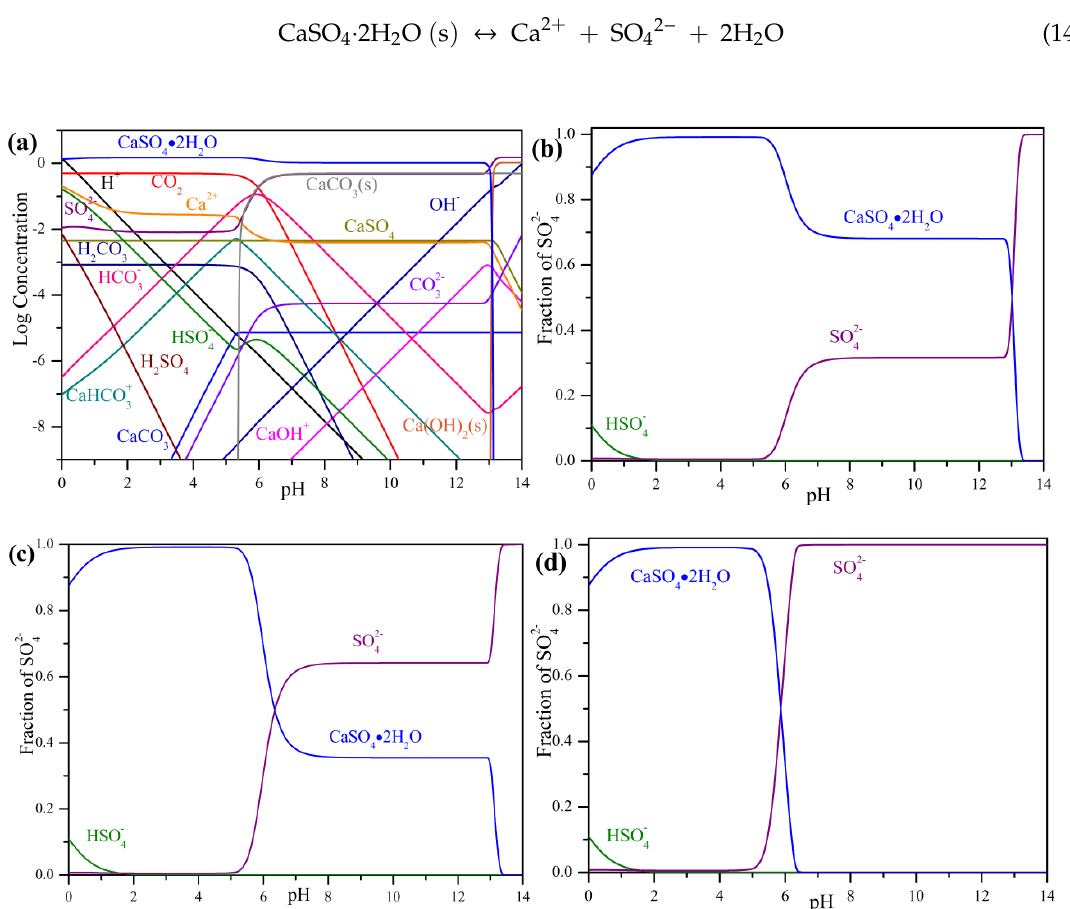
= 0.1 M with fraction of sulfate vs. pH; CO 2 = 2 M with fraction of sulfate vs. CO 2